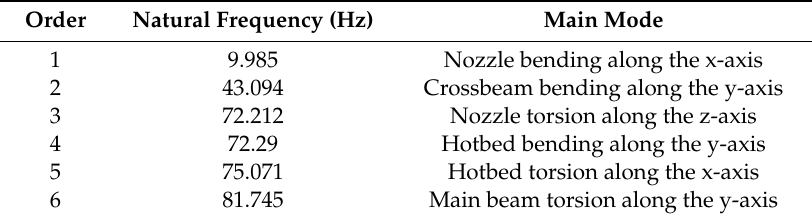
Table 2. Description of natural frequencies and modes of the top six order.